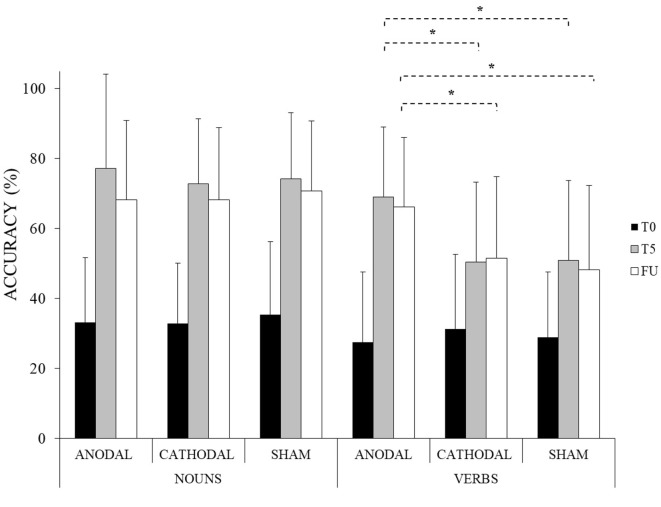
Mean percentage of response accuracy for nouns and verbs at baseline (T0), at the end of the treatment (T5) and at follow-up (FU) for the anodal, cathodal and sham condition, respectively (*<0.001). Error bars represent SD.